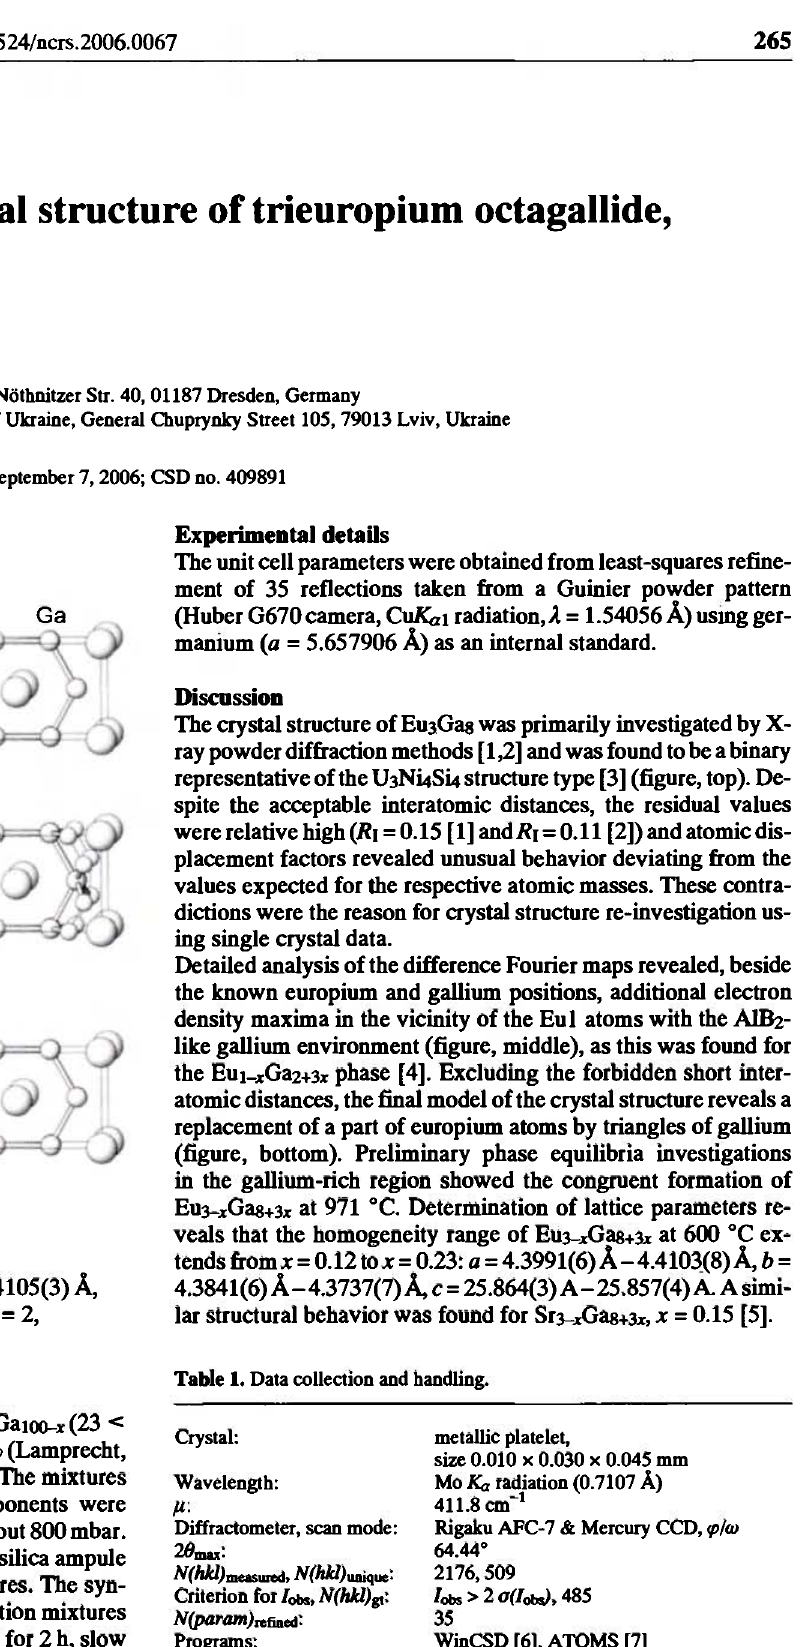
Table 2. Atomic coordinates and displacement parameters (in A 2